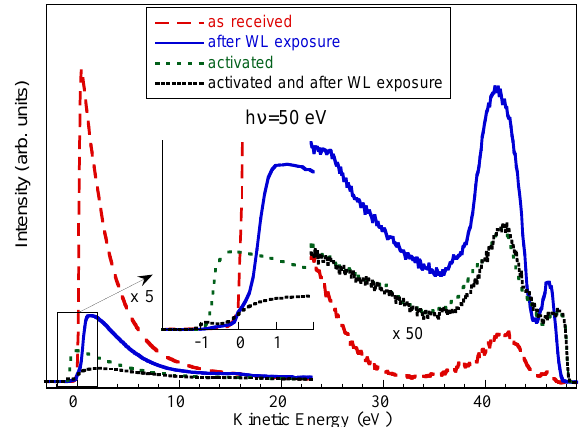
FIG. 8. (Color) The photoemission spectra, taken at 50 eV photon energy, of TiZr II as received, after WL exposure, after annealing in UHV (pressure during annealing was less than 5 3 10 2 9 mbar) at (cid:2) 300 6 30 (cid:3) ± C for 2.25 h (TiZr II-ac.), and after WL exposure of the annealed surface.